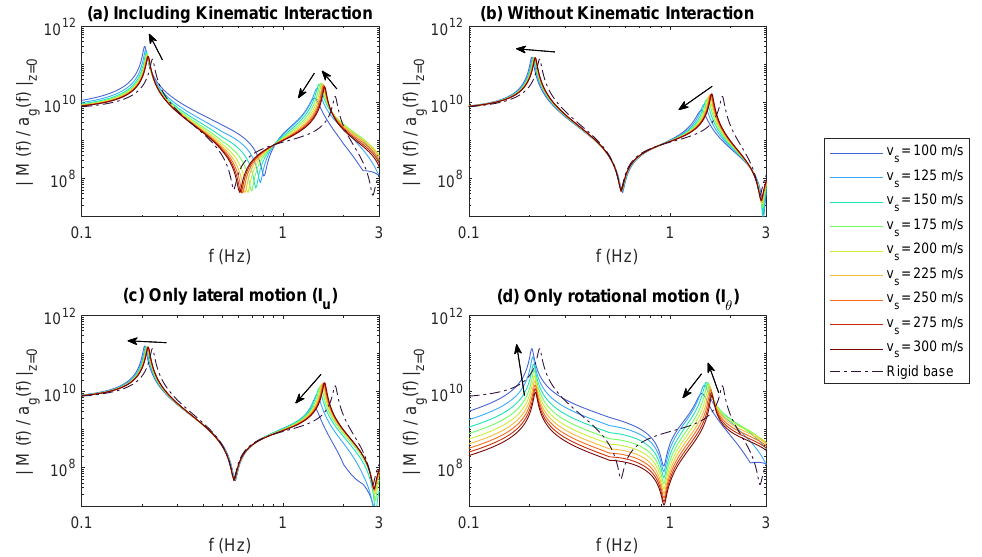
Figure 10. Frequency Response Functions for the bending moment at the mudline level. Analysis of the influence of the kinematic interaction and the soil stiffness. Case: 10